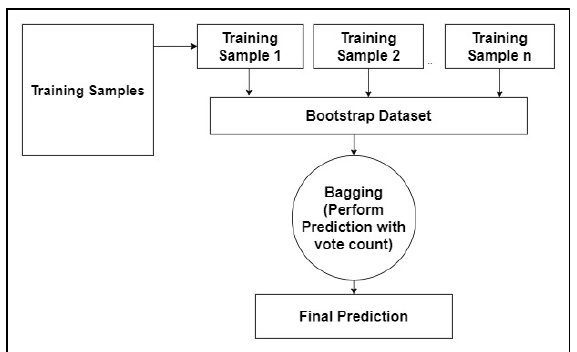
Figure 2. The random forest algorithm.